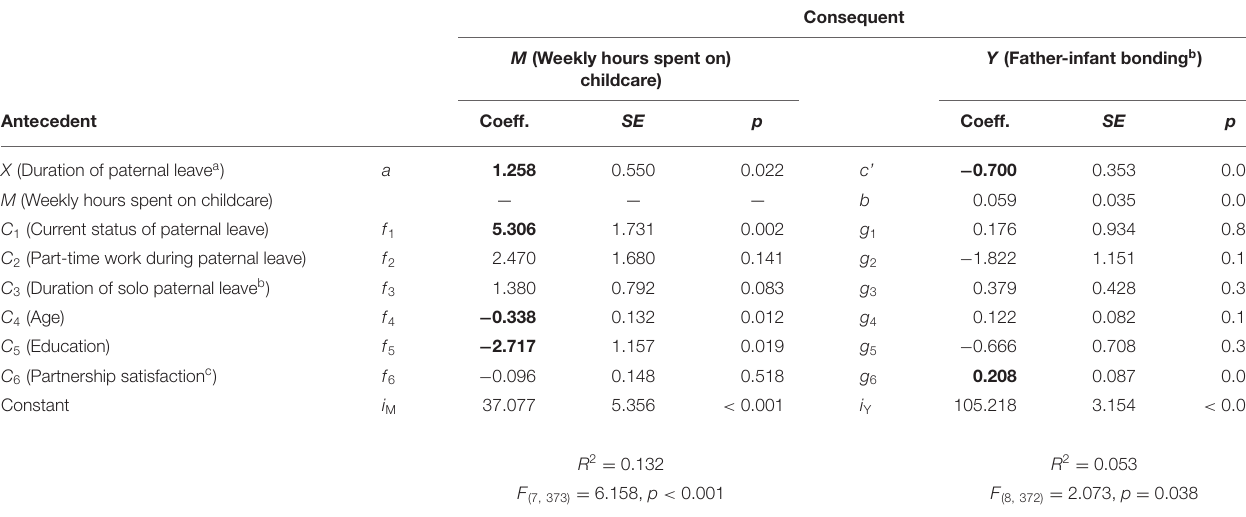
TABLE 4 | Model coefficients for the simple mediation analysis of the association between duration of paternal leave and father-infant bonding through weekly hours spent on childcare including six confounders.